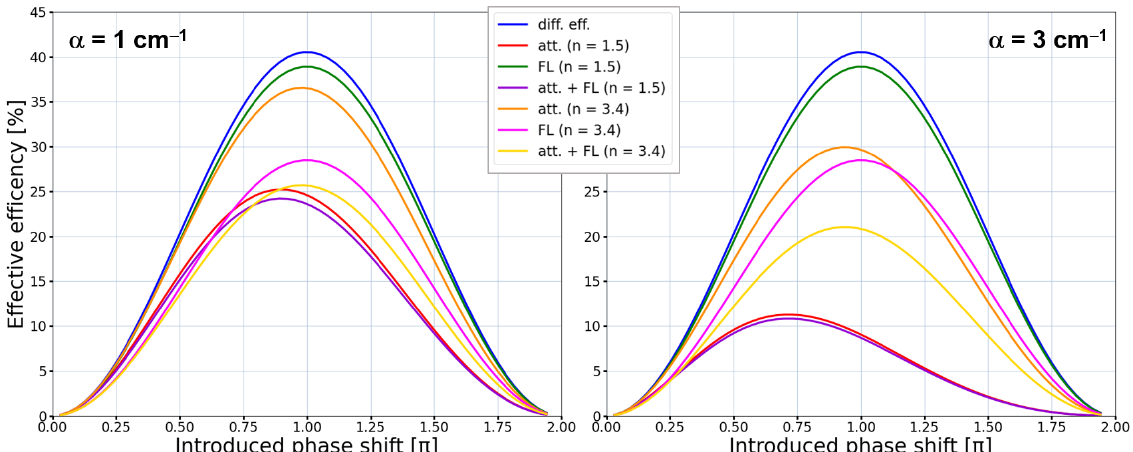
Figure 1. The effective efficiency of the binary phase diffractive element for two different absorption coefficient values: α = 1 cm − 1 ( left diagram) and α = 3 cm − 1 ( right diagram). The effective efficiency values are given under assumption of considering only diffractive efficiency (diff. eff.), attenuation introduced by the thickness of the structure resulting from absorption coefficient value (att.), Fresnel losses resulting from the reflection of part of the radiation of the interface between two media with different refractive indices (FL) and considering both—attenuation coefficient influence and Fresnel losses (att. + FL). It can be noticed that for materials with larger attenuation the effective efficiency is larger for structures with smaller phase shift than resulting from theoretical diffraction efficiency due to the attenuation of material. The influence of Fresnel losses is increasing with the increase of the refractive index